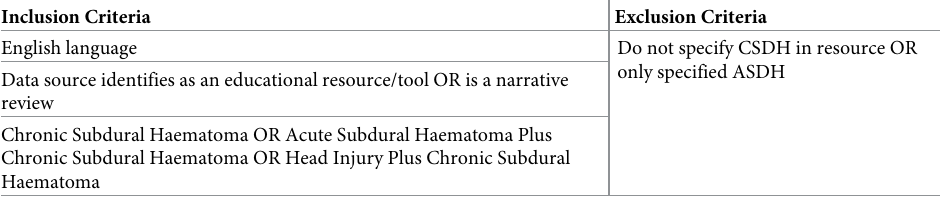
Table 1. Overall inclusion and exclusion criteria for screening resources to identify those with educational CSDH